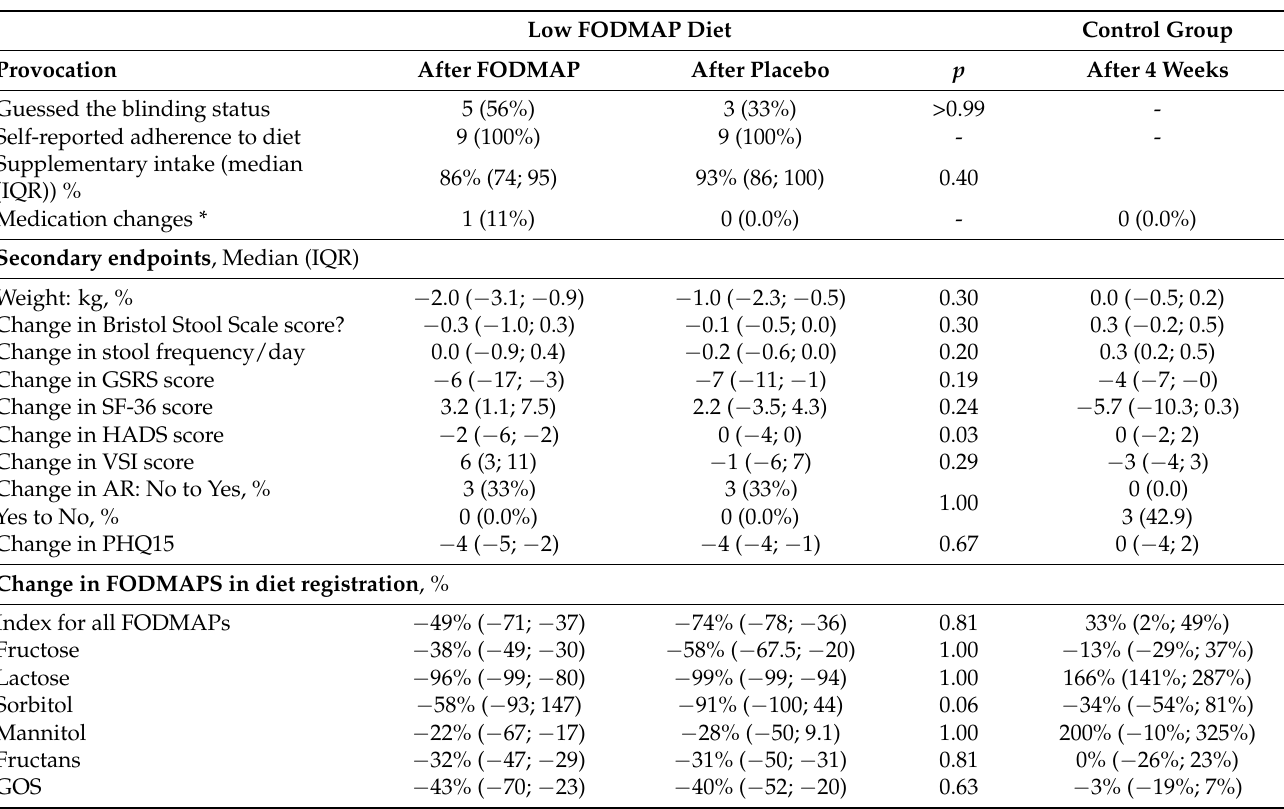
Table 3. Results after